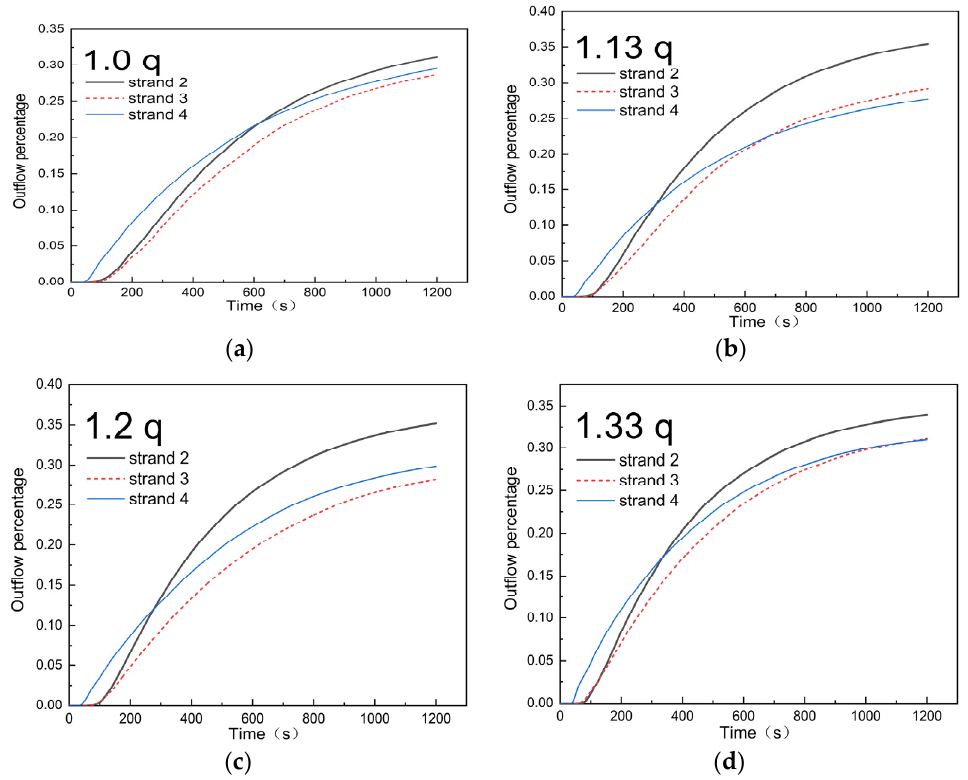
Figure 18. Outflow percentage curve of the u-shaped weir tundish with uniform increasing casting flow rate under strand 1 blockage condition: ( a ) 1.0 q, ( b ) 1.13 q, ( c ) 1.20 q, ( d ) 1.33 q.